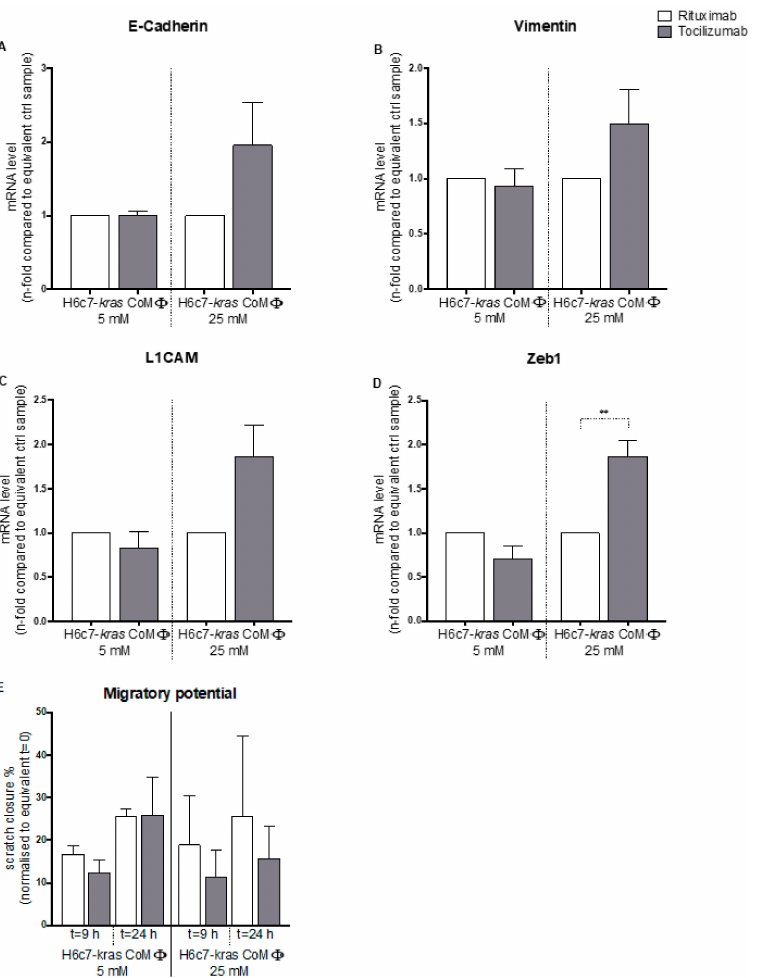
Figure 7. Blockade of IL-6 activity via Tocilizumab increases mRNA levels of epithelial and mes- enchymal markers in cocultured hyperglycemic H6c7- kras cells and reduces cell migration. H6c7- kras cells were cocultured with M1-polarized macrophages (M Φ ) for 5 days in normo- or hyperglycemic settings (5 or 25 mM of D -glucose) and treated with 1 µ g/mL of Tocilizumab or Rituximab. The ep- ithelial cells were separated from direct coculture via CD11b-MACS depletion of M1-M Φ and used for qPCR analysis. The relative mRNA levels of E-cadherin ( A ), Vimentin ( B ), L1CAM ( C ) and Zeb1 ( D ) are depicted, normalized to the housekeeping gene GAPDH and presented as n -fold expression compared with the equivalent control sample. In ( E ), the migratory potential of differentially cul- tured and treated H6c7- kras cells is shown. The migratory potential was monitored via scratch assay using the Lionheart FX Automated Microscope. Scratch closure was assessed at t = 0 h, t = 9 h and t = 24 h and data are expressed as % gap closure normalized to t = 0 h. Normally distributed data are presented as mean and standard error of mean. ** 0.0331 > p > 0.0021; n =